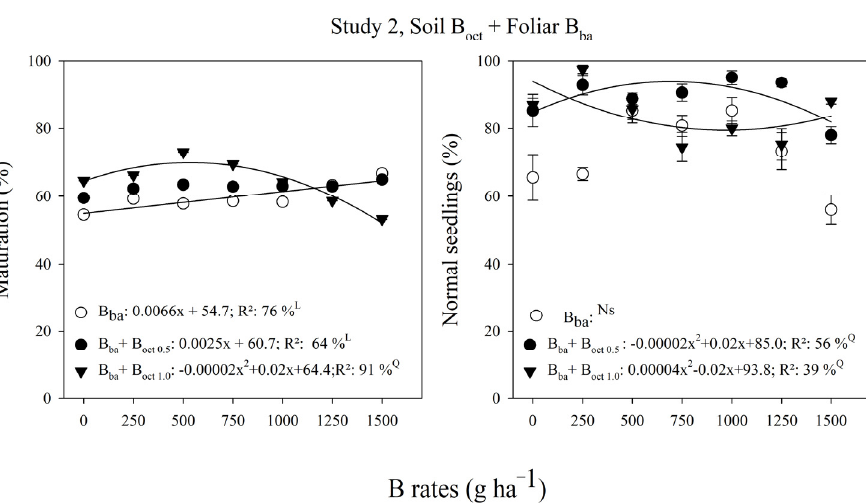
Figure 6. Maturation (%) and normal seedlings (%) in Study 2 with B application in soil using sodium octaborate (Boct) with two rates (Boct0.5: 0.5 kg ha − 1 ; and Boct1.0: 1.0 kg ha − 1 ), and the foliar B application using boric acid (Bba) with six rates (250, 500, 750, 1000, 1250, and 1500 g ha − 1 ). L, Q, and N stand for, respectively, linear and quadratic models, and no significant response. Averages presented with error variation. Boct0.5 = sodium octaborate at 0.5 kg ha − 1 ; Boct1.0 = sodium octaborate at 1.0 kg ha − 1 .